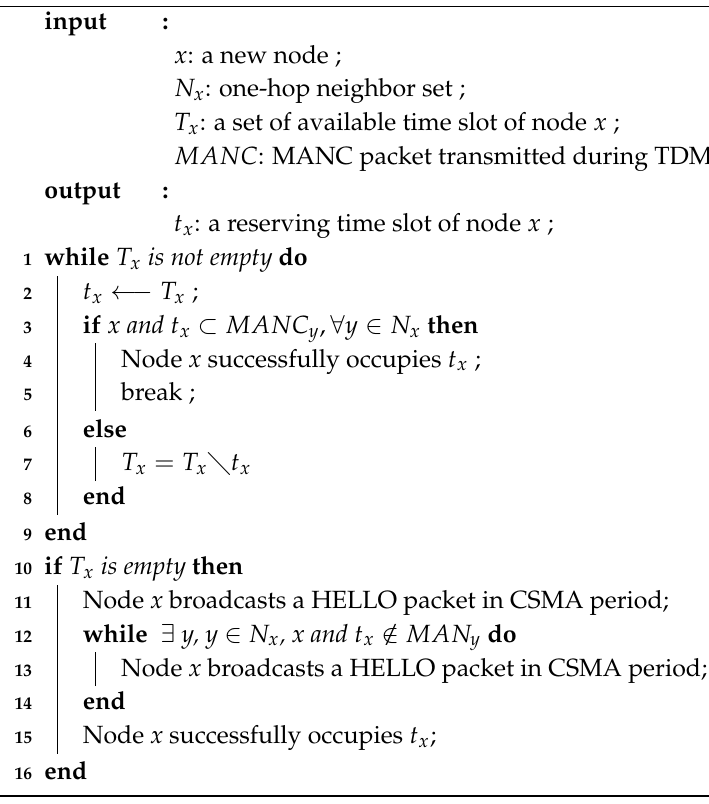
Algorithm 1: Hybrid time slot acquisition